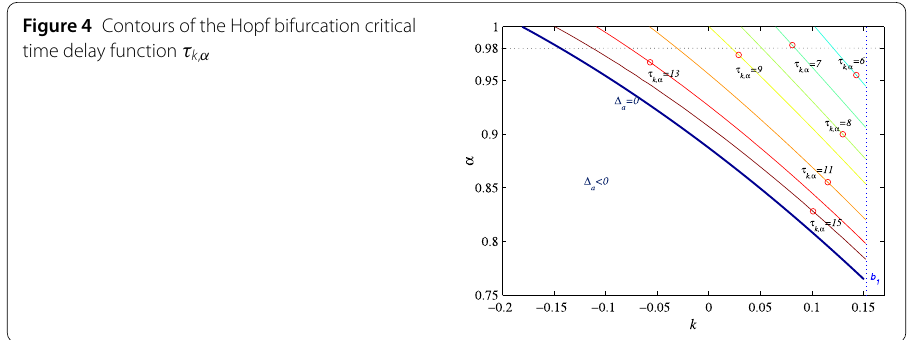
Table 1 Effect of feedback control gain on the Hopf bifurcation critical value Feedback gain k Critical frequency ξ a Bifurcation point τ k ,0.98 –0.14